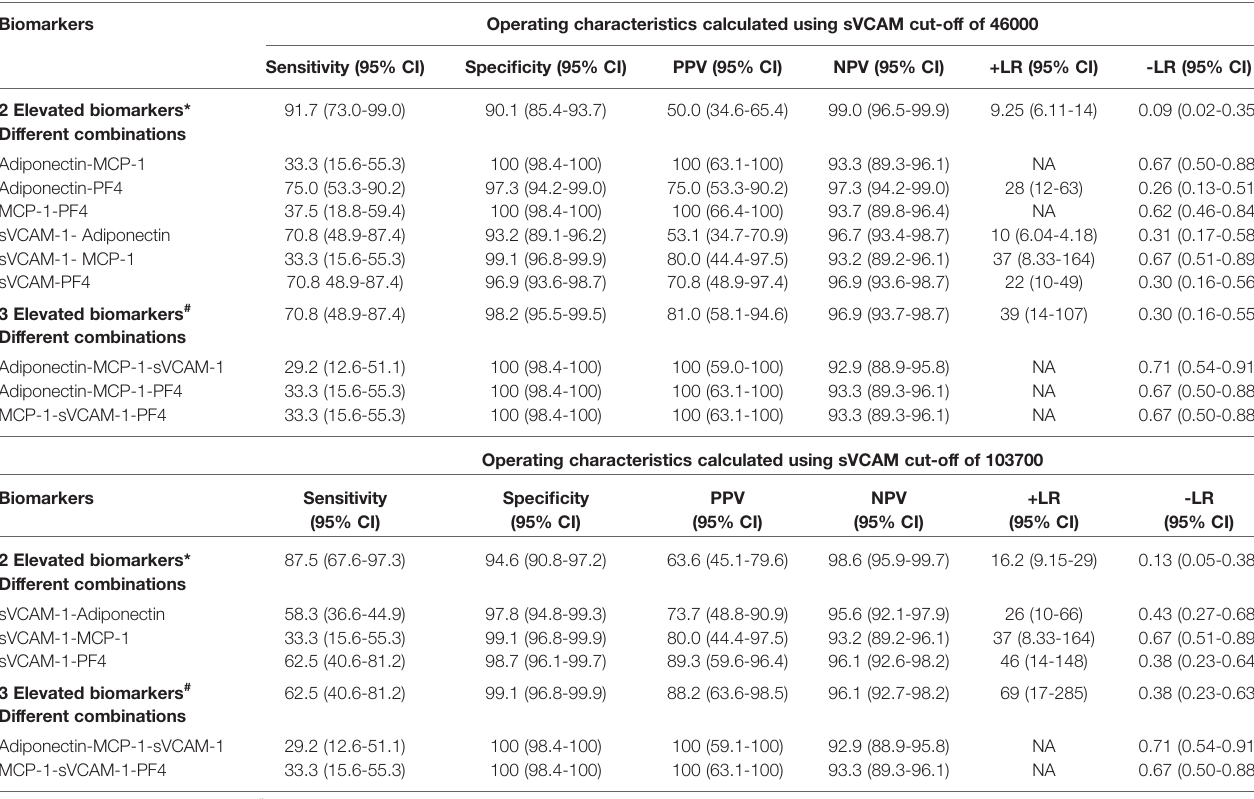
TABLE 4 | Operating characteristics for different combinations and number of elevated urinary biomarkers to accurately detect ALN patients. Biomarkers